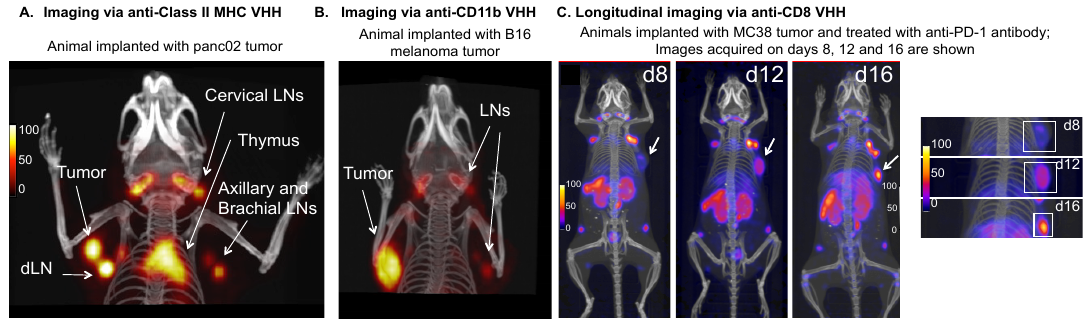
Figure 6. PET-CT scans of tumor bearing animals imaged with radiolabeled nanobodies. A) 18 F-labeled anti-Class II MHC nanobody detects very small tumors and lymphoid organs with great clarity [118]. B) 18 F-labeled anti-CD11b nanobody detect B16 melanoma tumor by virtue of detecting tumor infiltrating myeloid cells [119]. C) 89 Zr-labeled PEGylated anti-CD8 nanobody can be used to longitudinally monitor the dynamics of CD8 + cells in response to PD-1 blockade [120]. White boxes show the tumor. For more images and data-quantification see refs [119,121,120].